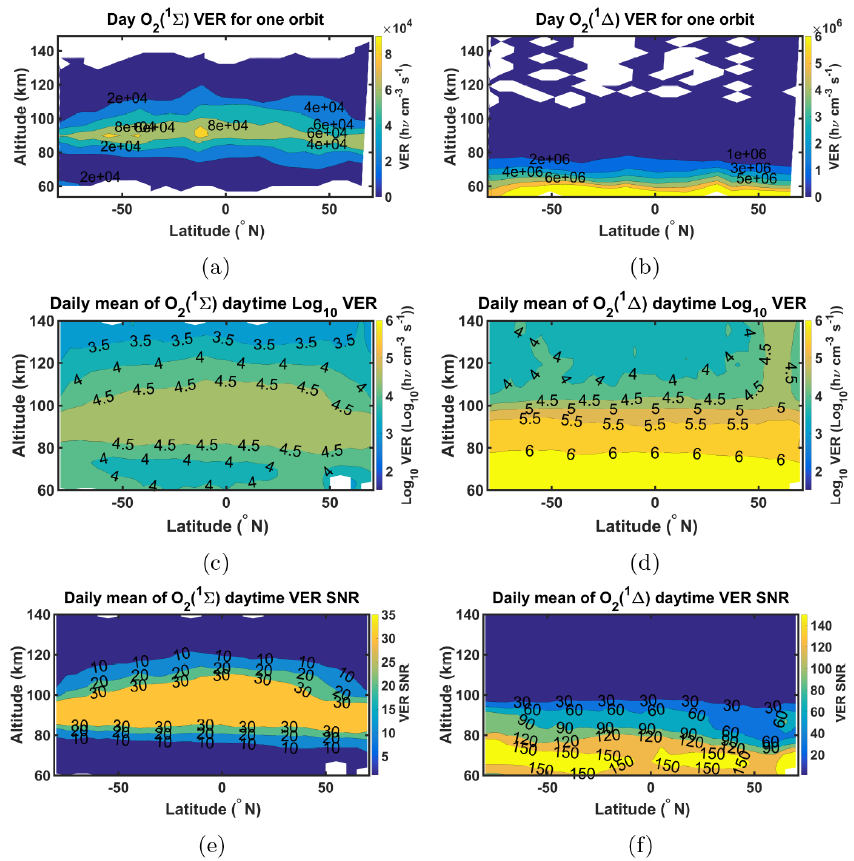
Figure 6. Latitude–altitude contours of the daytime VER. (a) for the O 2 ( 1 (cid:54)) band and for one satellite orbit on the date 3 February 2010; orbit number 41455. (b) as (a) for O 2 ( 1 (cid:49)) . Signal-to-noise ratios less than 1 and large noisy values are excluded. (c) and (d) as (a) and (b) respectively, averaged on all of the orbits on the whole day of 3 February 2010, with the same logarithmic scale. Negative values are excluded. (e) Signal-to-noise ratios of the daily mean of O 2 ( 1 (cid:54)) VERs. Areas where the signal-to-noise ratio is less than 1 are plotted in white. (f) as (e) for the O 2 ( 1 (cid:49))